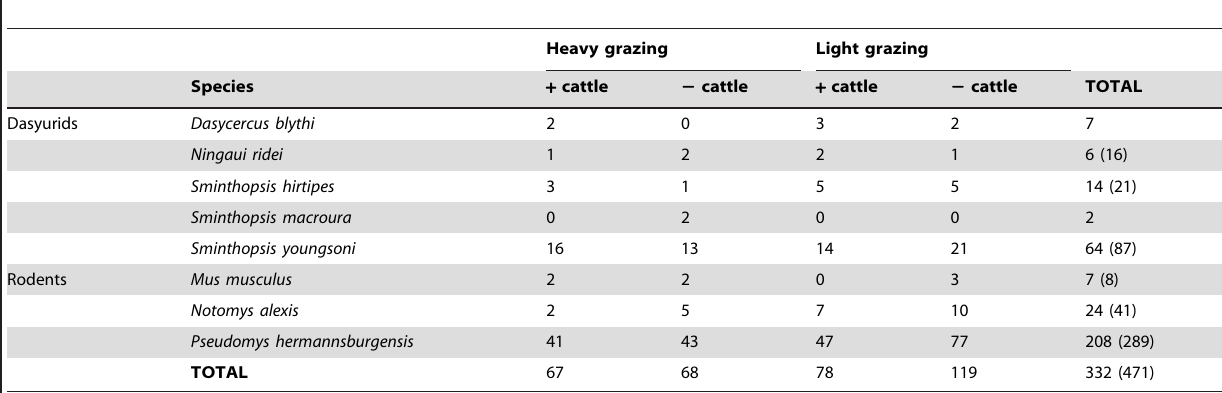
Table 3. Total captures of small mammals under different grazing histories and cattle removal